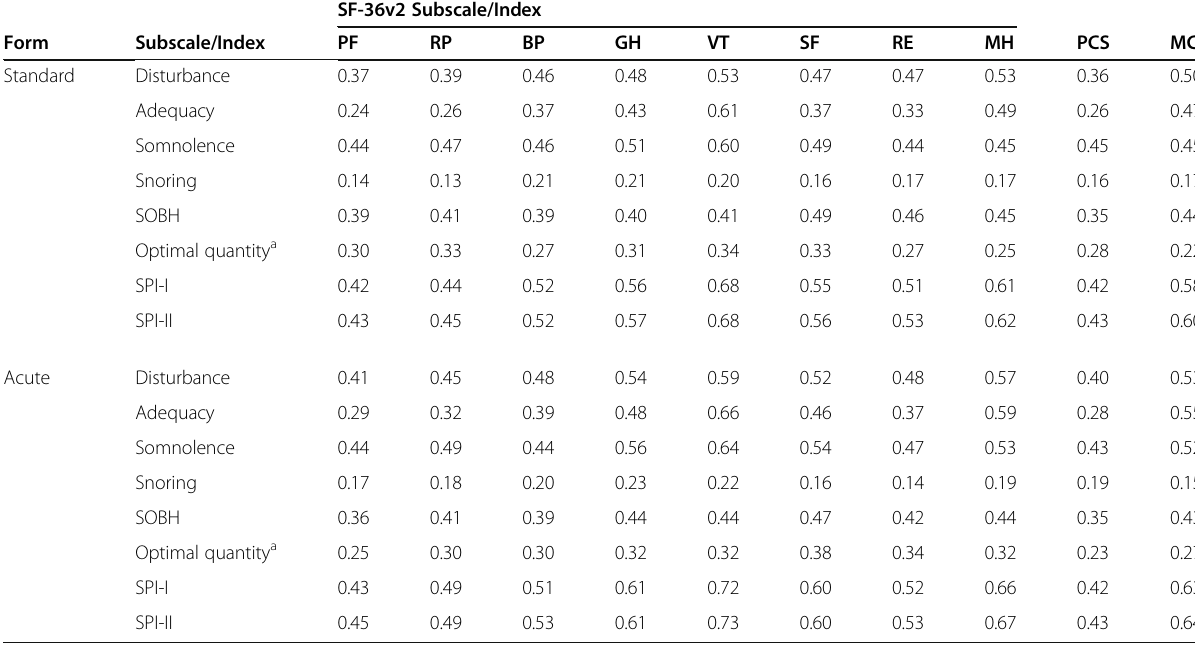
Table 6 Correlation coefficients between MOS Sleep-R and SF-36v2 standard and acute form subscales and summary measures SF-36v2